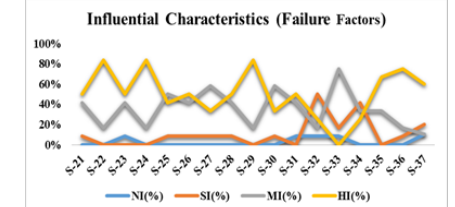
Figure 6: Influential Characteristics and their Properties of S.1 to S.37 (Source: Primary Data) Interpretation: According to the observation of the teachers of Rabindra University, Bangladesh (RUB), the factors such as interest in study (92%), regular study (100%), hard work, dedication & Self-Confidence (92%) are the most influential factors that affect the academic performance of the undergraduate students. Academic routine (67%), timely and regular preparation for examination (67%), adequate class works (i.e., class tests, assignments & presentations, field works (67%), time for consultation with teachers (67%) are